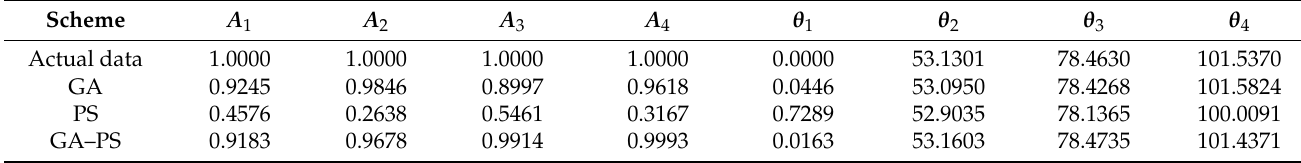
Table 5. Comparison of DOAs achieved using GA, PS, and GA–PS.